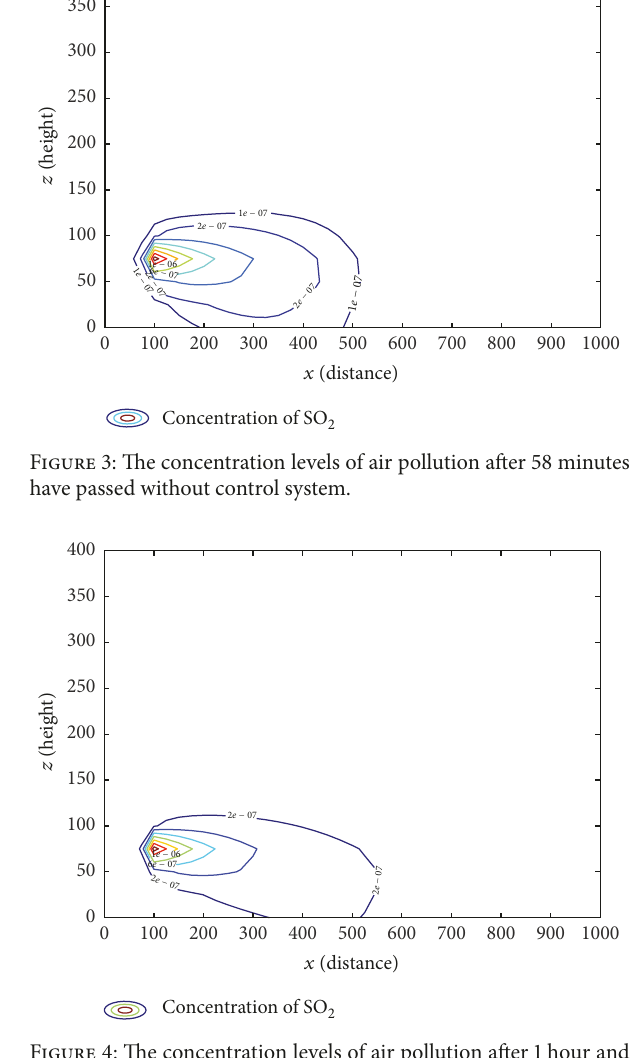
Figure 4: The concentration levels of air pollution after 1 hour and 36 minutes have passed without control